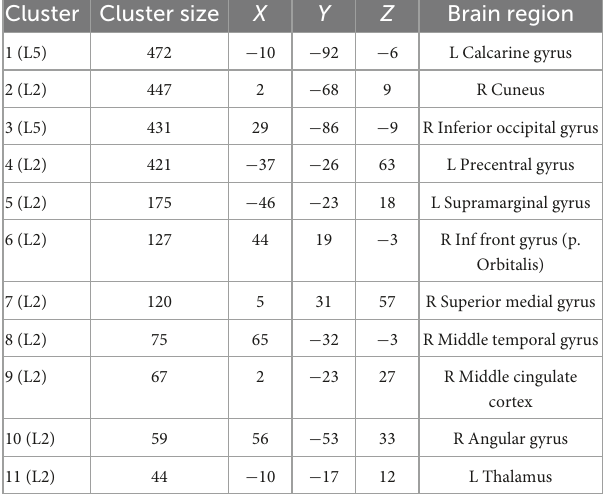
TABLE 3 Individual Talairach coordinates (mm) of functional magnetic resonance imaging (fMRI)-weighted dipole fits for the delay condition. Right Left x y z x y